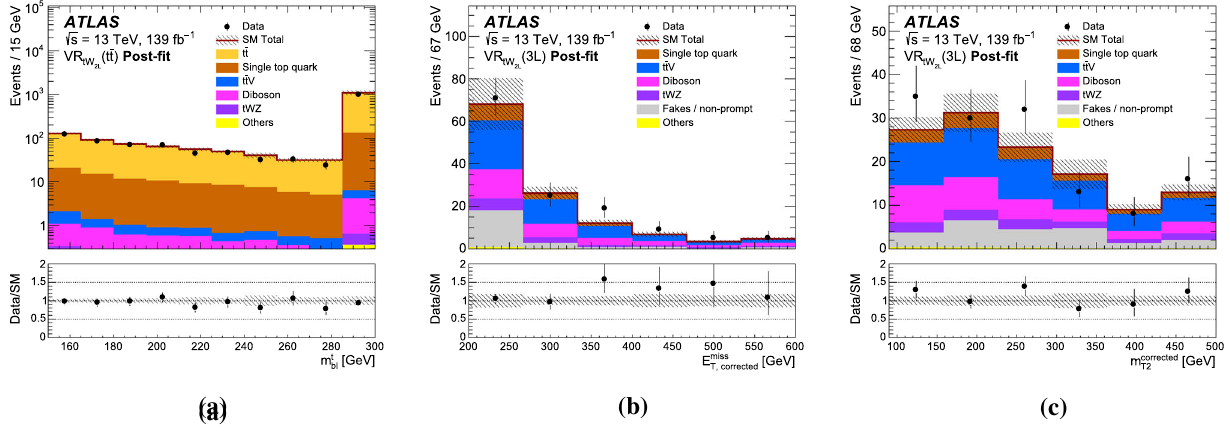
Fig. 4 The kinematic distributions in the t ¯ t and 3 (cid:7) validation regions of the tW 2L analysis channel after the background-only fit: a m t in b (cid:7) ( t ¯ t ) , b E miss ( 3L ) and c m ( 3L ) . The in VR tW VR tW T2 in VR tW 2L T 2L 2L uncertainty bands plotted include all statistical and systematic uncer-